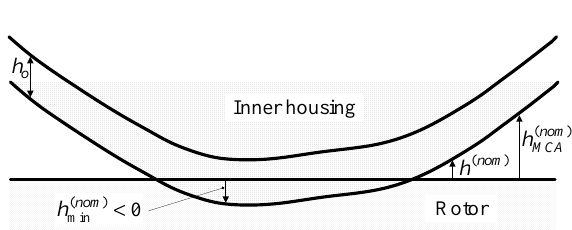
Figure 10: Illustration of h ( nom ) , h ( FSI ) and h o